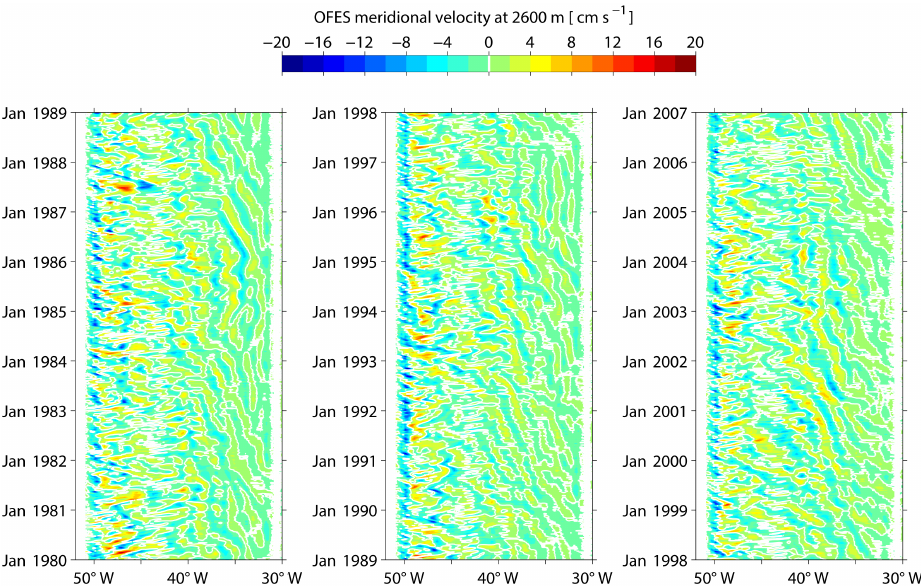
Figure 14. Hovmoller plot illustrating the OFES model meridional velocity along 34.5 ◦ S at the core of the NADW near 2600m depth. Velocities are shown for the final 27 years of the run discussed in the text, broken into three 9-year panels. White contours indicate zero